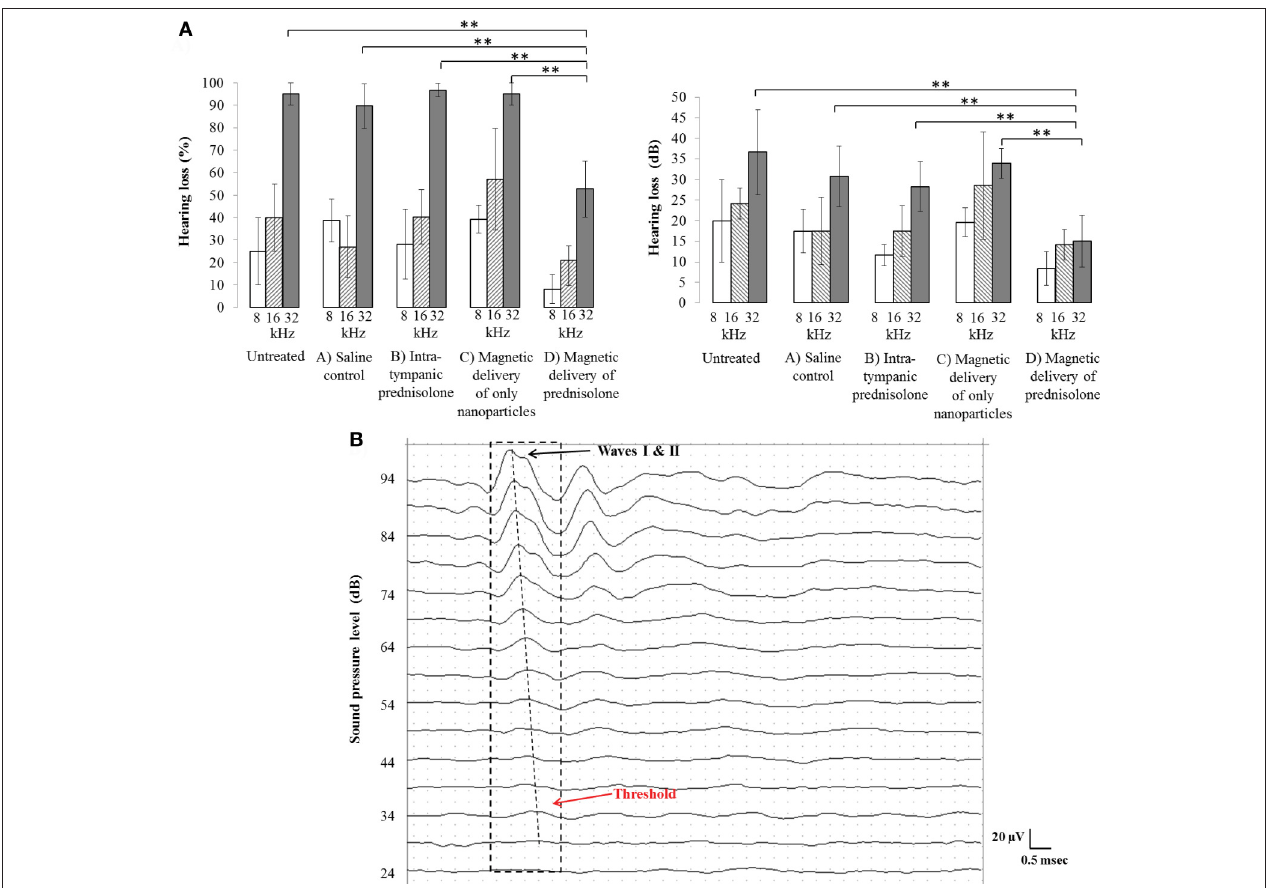
FIGURE 1 | (A) Comparison of hearing loss between the four animal groups for the injected left ears and corresponding untreated right ears. Percent hearing loss at each frequency (Left) and the corresponding hearing loss in dB (Right), per group, are shown. Treated ears that received magnetic nanoparticles showed significantly less hearing loss (group D bars), as compared to the only nanoparticle group (group C bars, ** p < 0.05), the intra-tympanic methyl-prednisolone group (group B bars, ** p < 0.05), and the saline control group (group A bars, ** p < 0.05), especially at the high frequency of 32 KHz. Hearing loss remained similar at high frequency across all groups for untreated ears. (B) A sample ABR trace containing the waves I and II (dotted black box) at 16 KHz has been shown, to demonstrate the threshold measurement (note that positive voltage is up, the convention for animal ABRs). The threshold for this animal is at 34 dB beyond which the waves I and II are completely